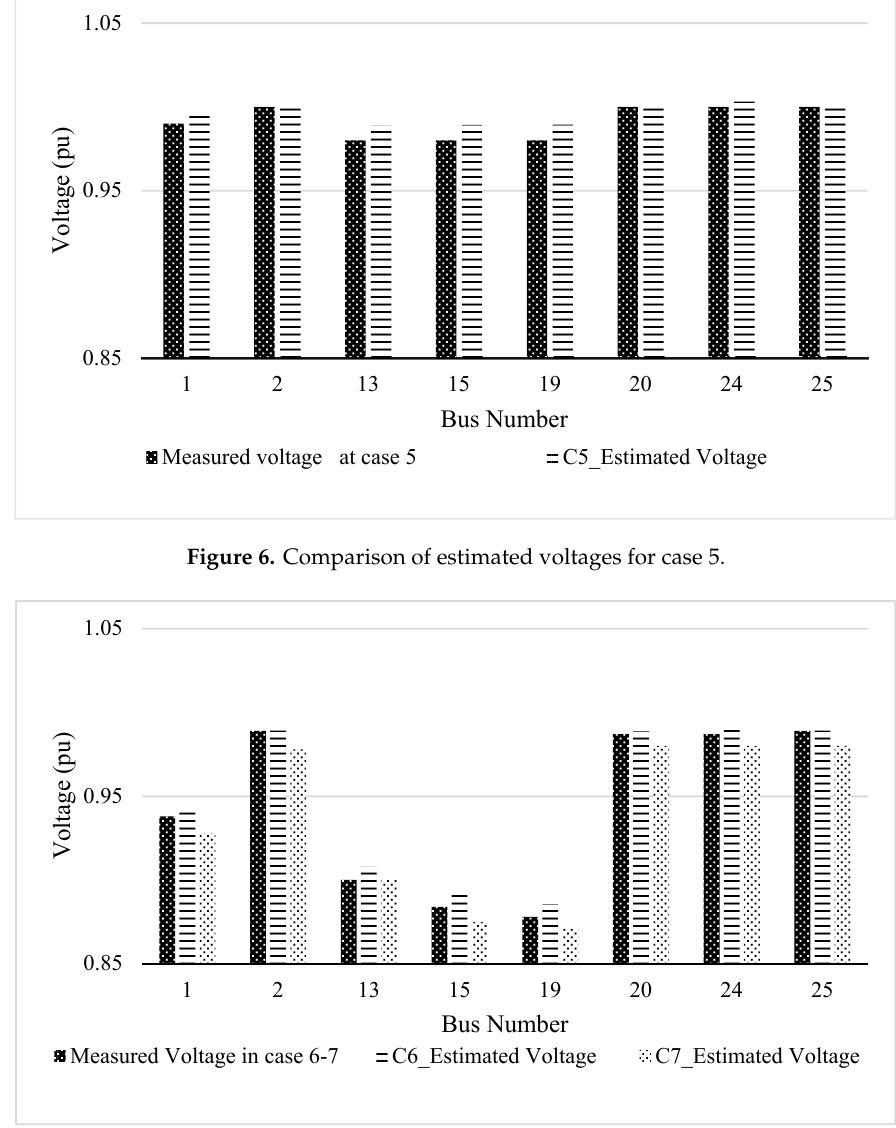
Figure 7. Comparison of estimated voltages for cases 6 and 7.